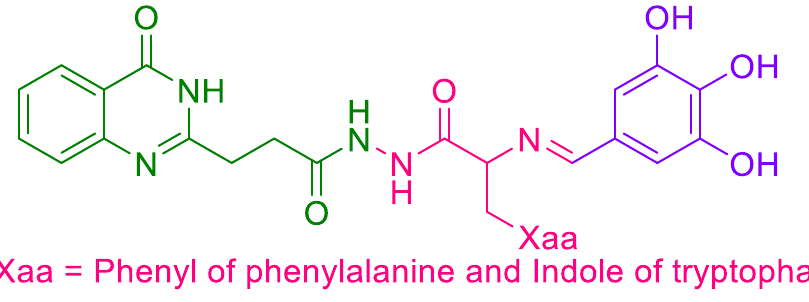
Figure 85. Amino acids-quinazolinone-Schiff bases. Rakesh K P et al. synthesised two novel series of peptides conjugated to quinazoli- nones ( 106 ) (QZNs-Gly-X-Gly-Val-Pro-OBzl/OH) by varying different amino acids at the second position of the peptide (i.e., X position) in the GXGVP peptide template (Figure 86). Amino acids used in the X position possessed different charge, polarity and hydropho- bicity. The new conjugates were evaluated as potent antioxidant and anti-inflammatory agents. Among the synthesised molecules, those having Asp at the second position of the peptide chain and free carboxyl C-terminus with butyl group in the heterocyclic part was reported to be a good anti-inflammatory agent (IC 50 = 20 ± 0.65 µ g/mL). On the other hand, molecules having Trp residue at the X position of the peptide chain turned out to be highly potential radical scavengers (IC 50 = 25 ± 1.18 µ g/mL). The authors have also sug- gested that the molecules having charged species reduces inflammation property, whereas molecules with higher hydrophobicity favours the antioxidant property. Furthermore, the lead molecules having butyl group in the heterocycle and with free C-terminus in the peptide moiety reported good anti-inflammation property